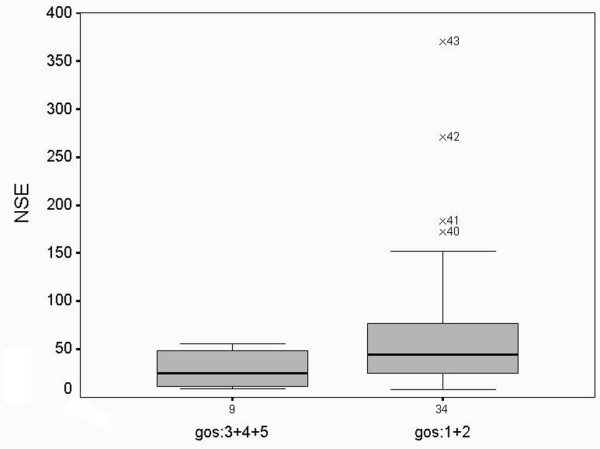
Neuron-specific enolase levels (ng/ml) after in-hospital cardiac arrest. Median, interquartile ranges and 5 to 95% centiles are shown. GOS, Glasgow outcome scale.